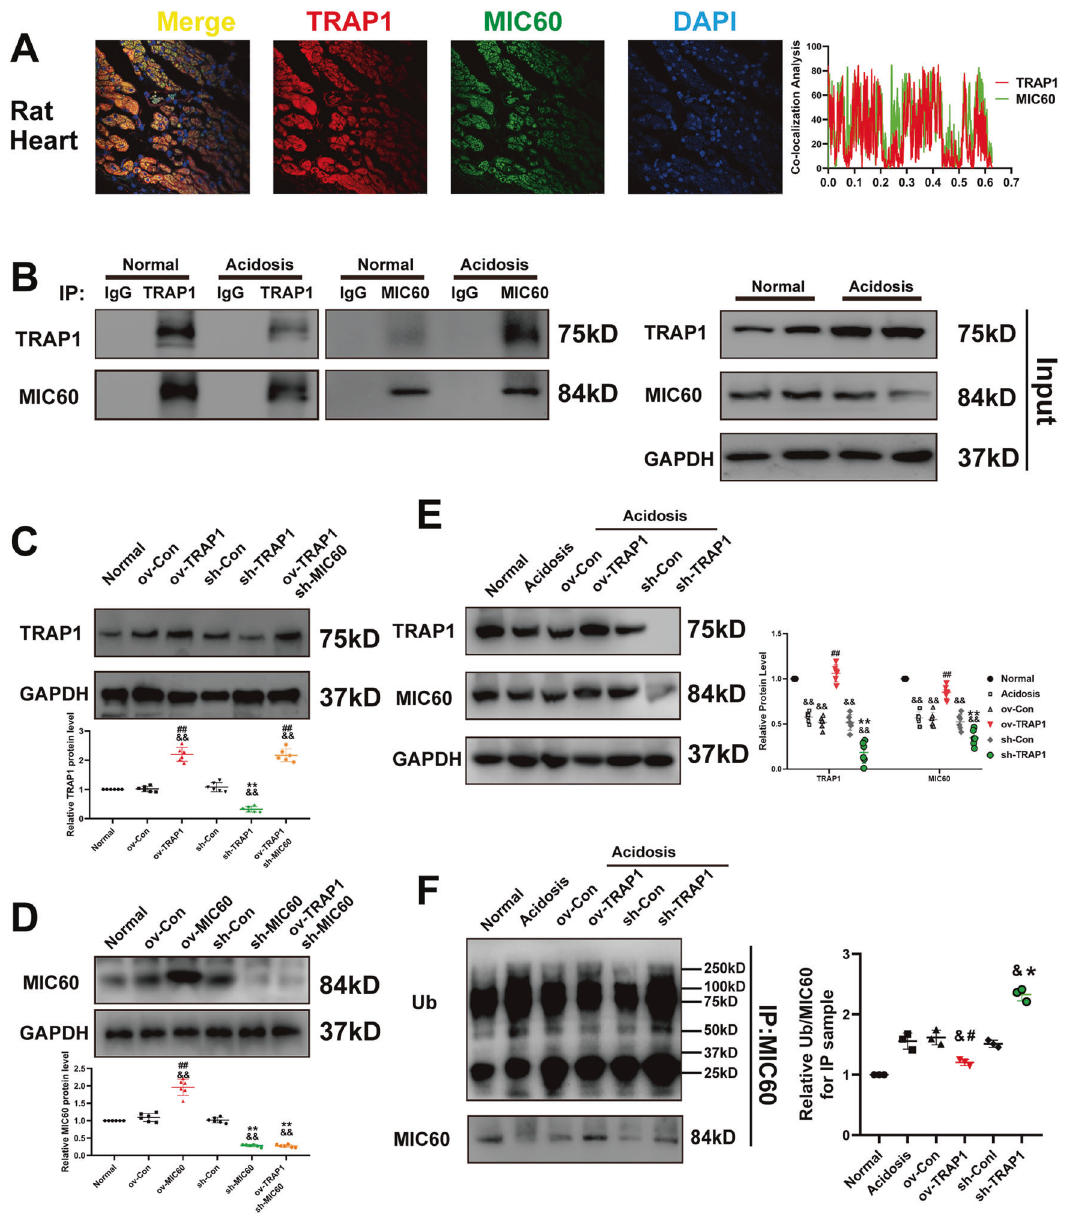
Fig. 5 TRAP1 interacted with MIC60 and decreased MIC60 ubiquitination to increase MIC60 protein levels in rats ’ heart tissue in extracellular acidosis. A Detection of the colocalization of MIC60 (green) and TRAP1 (red) using confocal microscopy in rat ’ s heart tissue. B Immunoblotting analysis of TRAP1 and MIC60 expression in a co-IP assay performed in protein lysate of rat ’ s heart tissue with anti-TRAP1 or anti-MIC60 Magnetic beads, respectively. C – D Western blot was used to determine the transfection ef fi ciency of TRAP1 ( C ) and MIC60 ( D ) in rats ’ heart tissue. E Western blotting was used to detect MIC60 protein levels regulated by TRAP1. F Western blot was used to detect MIC60 protein ubiquitination. Data were the means ± SD from three independent experiments. Group comparisons were performed by one-way analysis of variance followed by Tukey ’ s post hoc test. & P < 0.05 vs. Normal group. # P < 0.05 vs. ov-Con group. ## P < 0.01 vs. ov-Con group. * P < 0.05 vs. sh-Con group. ** P < 0.01 vs. sh-Con group. RNA isolation, reverse transcription (RT), and quantitative (2) ACGGCAAGTTCAACGGCACAG and CGACATACTCAGCACCAGCATCAC for rat GAPDH; real-time qPCR (RT-qPCR) (3) AGGTGTGGTGGACAGTGAGGAC and GCATTCGGCTGGCGTAGTCTG for Total cellular RNA was extracted using TRIzol reagent (15596018, rat TRAP1. Invitrogen) and total RNA density was detected using Nanodrop (Thermo). Then RT-PCR were conducted using a kit (RR036A, Takara). Real-time quantitative PCR (RT-qPCR) was carried out using another kit (RR420A, Takara). And the primer pairs used were listed: Western blot and protein half-life analysis Protein lysate containing 20 μ g total proteins were boiled at 95 °C for 10 min with 5× SDS-PAGE loading buffer, then separated in 6 or 8% (1) TCAGTCAGAGGCTAAGGTGGTGTC and TGGAGAGTGTGCCAGCTAGG sodium dodecyl sulfate-polyacrylamide gel electrophoresis (SDS-PAGE). TC for rat MIC60;